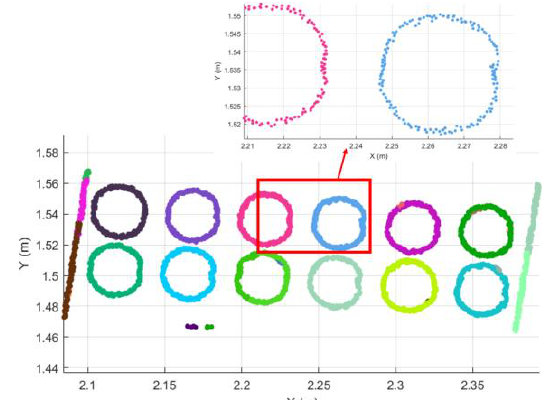
Figure 8: Points grouped by connectivity, pinching visible on either side of some drill